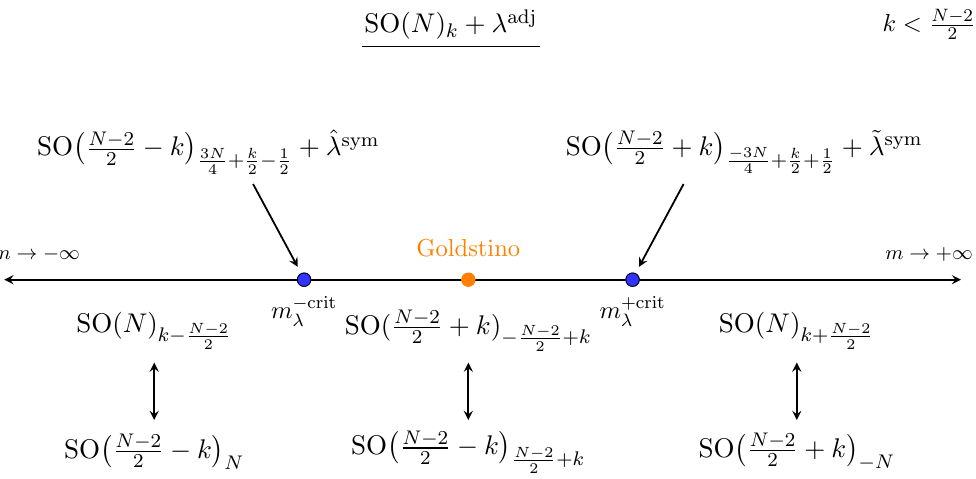
Figure 3 . The proposal of [4] for the Phase diagram of SU( N ) k gauge theory with a single real adjoint fermion for k < N= 2. There are two phase transitions each described by a weakly-coupled dual gauge theory description, which appears with an arrow pointing to the phase transition. The intermediate phase from each dual descriptions are related by level/rank duality.